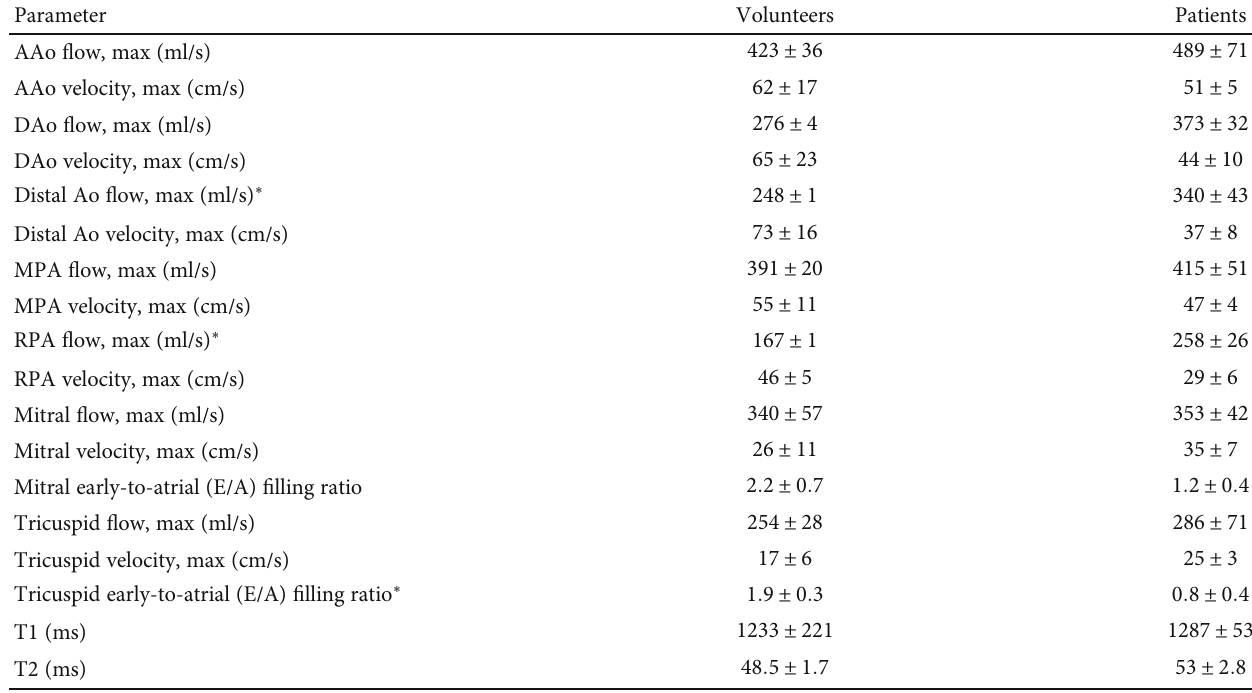
Table 2: Measurements ( mean ± SD ) of di ff erent cardiovascular parameters in volunteers and patients. Asterisks indicate statistical signi fi cance ( P < 0 : 05